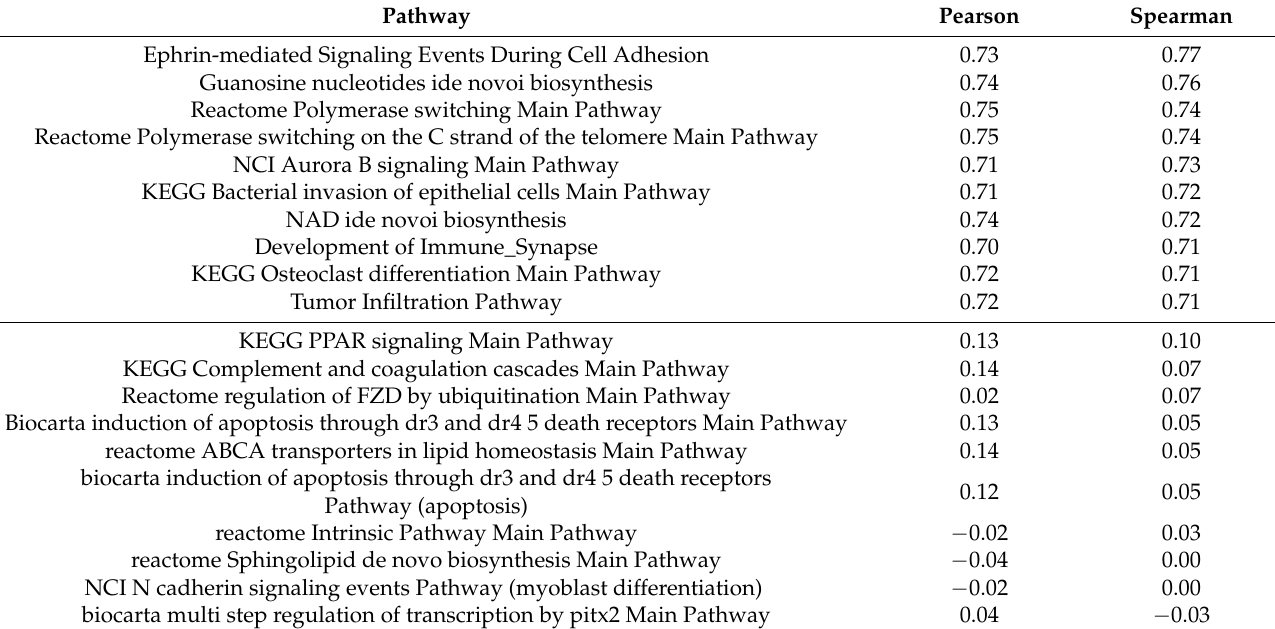
Table 1. “Top-10” of the most and the least correlated molecular pathways between RNA and protein expression data calculated for Breast Invasive Carcinoma biosamples.